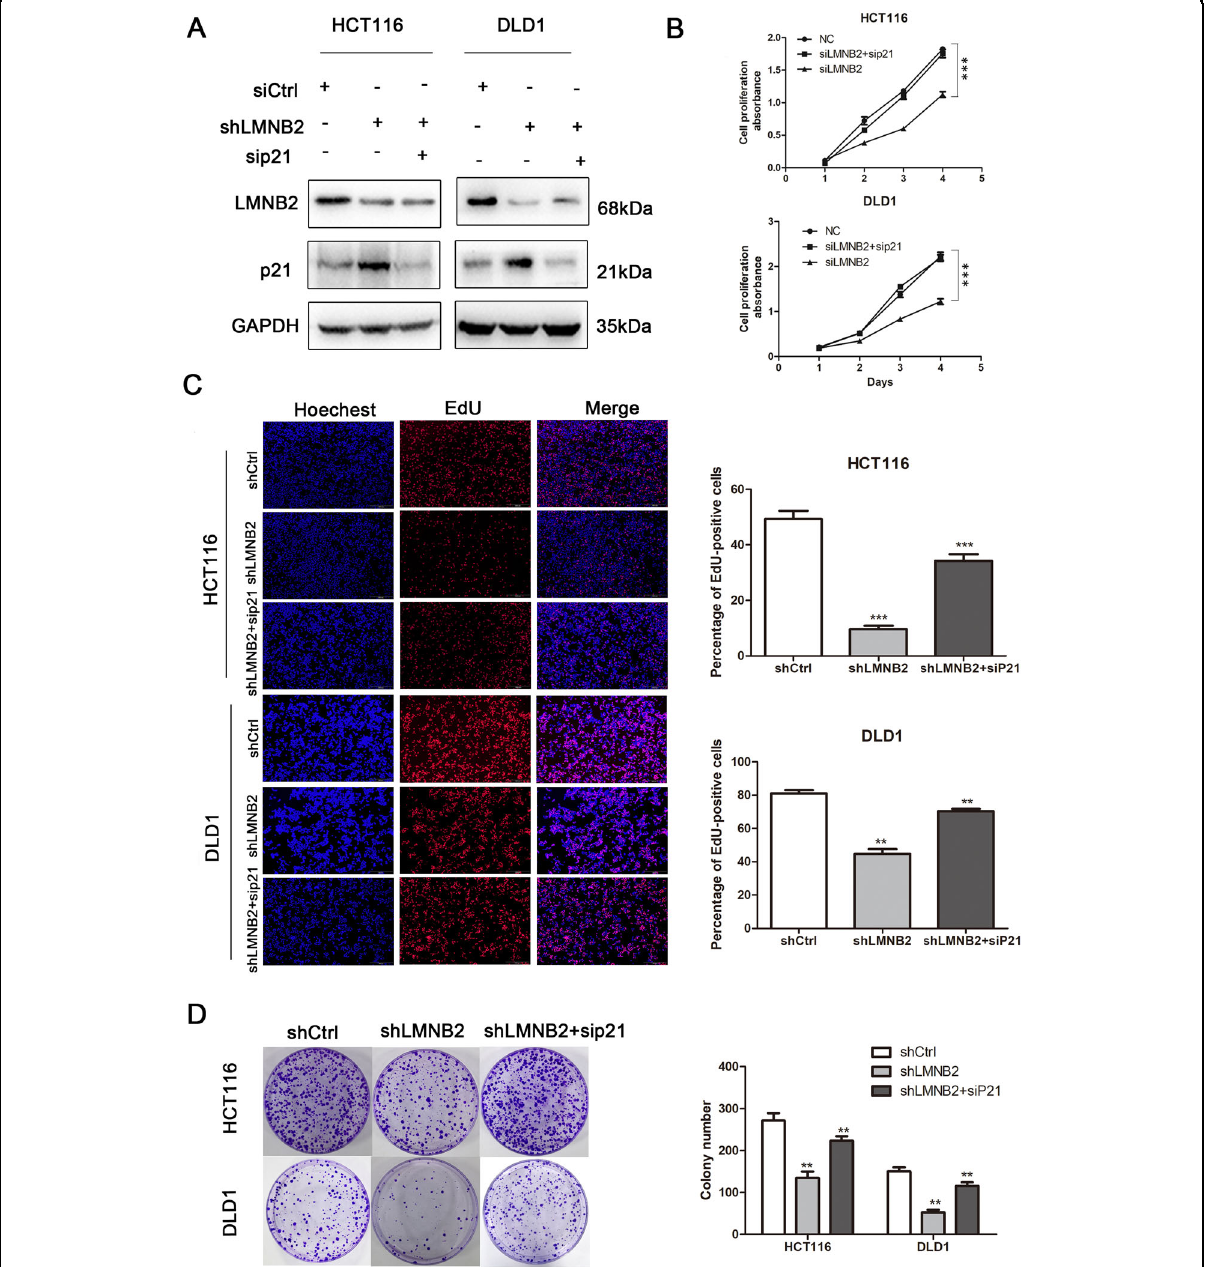
Fig. 6 Downregulation of p21 can reverse the inhibition of proliferation caused by LMNB2 gene knockout. A Western blotting con fi rmed the presence of LMNB2 and p21 gene knockout in HCT116 and DLD1 stable cell lines at the protein level. B – D Transiently transfected with p21 siRNA can reverse the inhibitory effect of LMNB2 gene knockout on the proliferation of HCT116 and DLD1 cells. The data is shown as the mean ± standard deviation from three independent experiments. * P < 0.05, ** P < 0.01, * P <